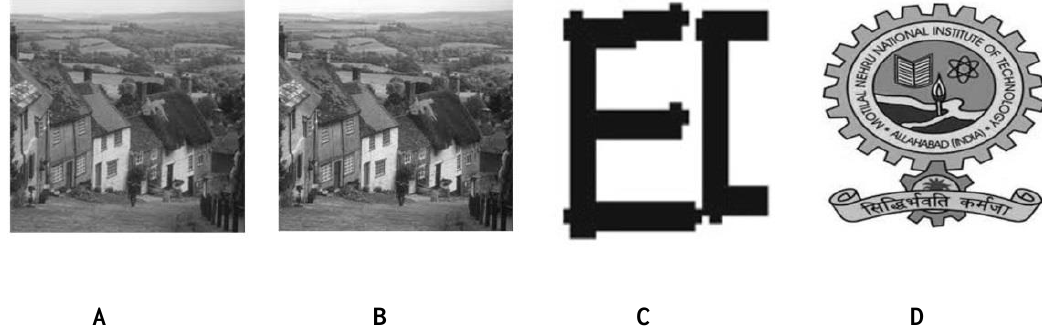
Figure 5: (A) Original Goldhill Image (B) Watermarked Image (C) Recovered EC Logo (D) Recovered MNNIT Logo.